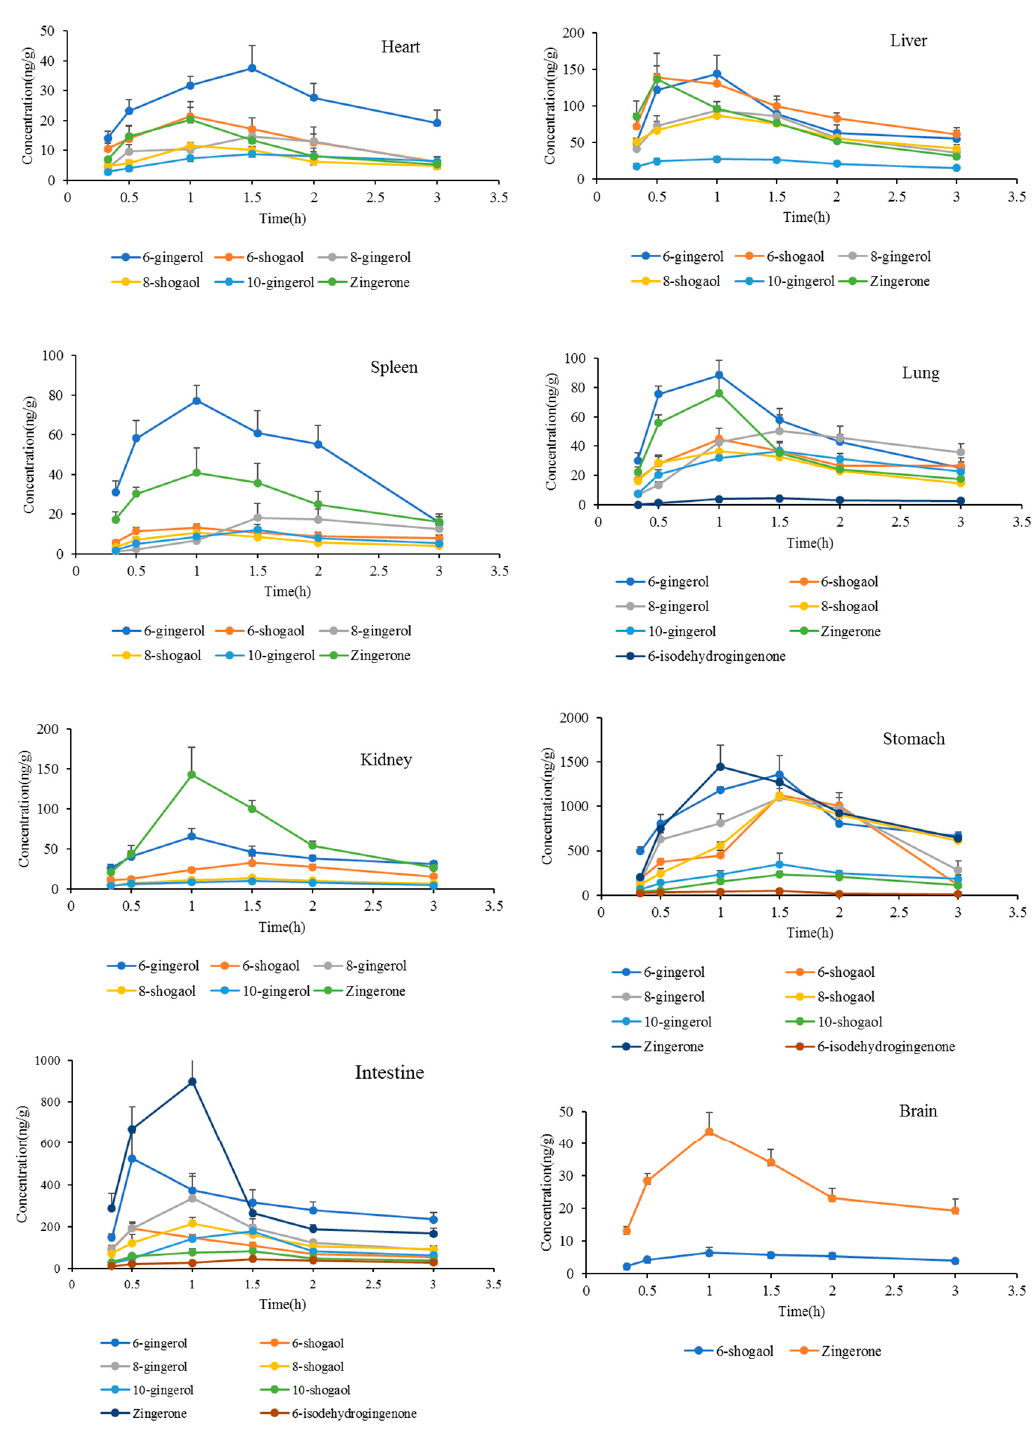
Figure 4. The concentrations of analytes in various tissues at different time points ( n = 6, mean ±